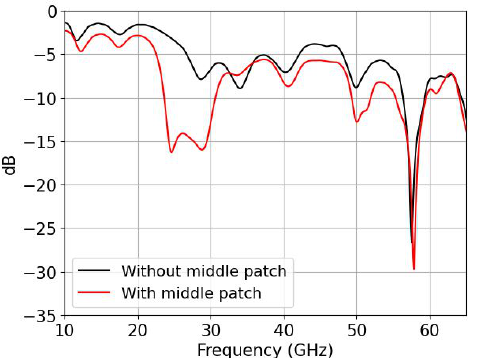
Figure 3. Input reflection coefficients without overlapping (black) and with overlapping (red).